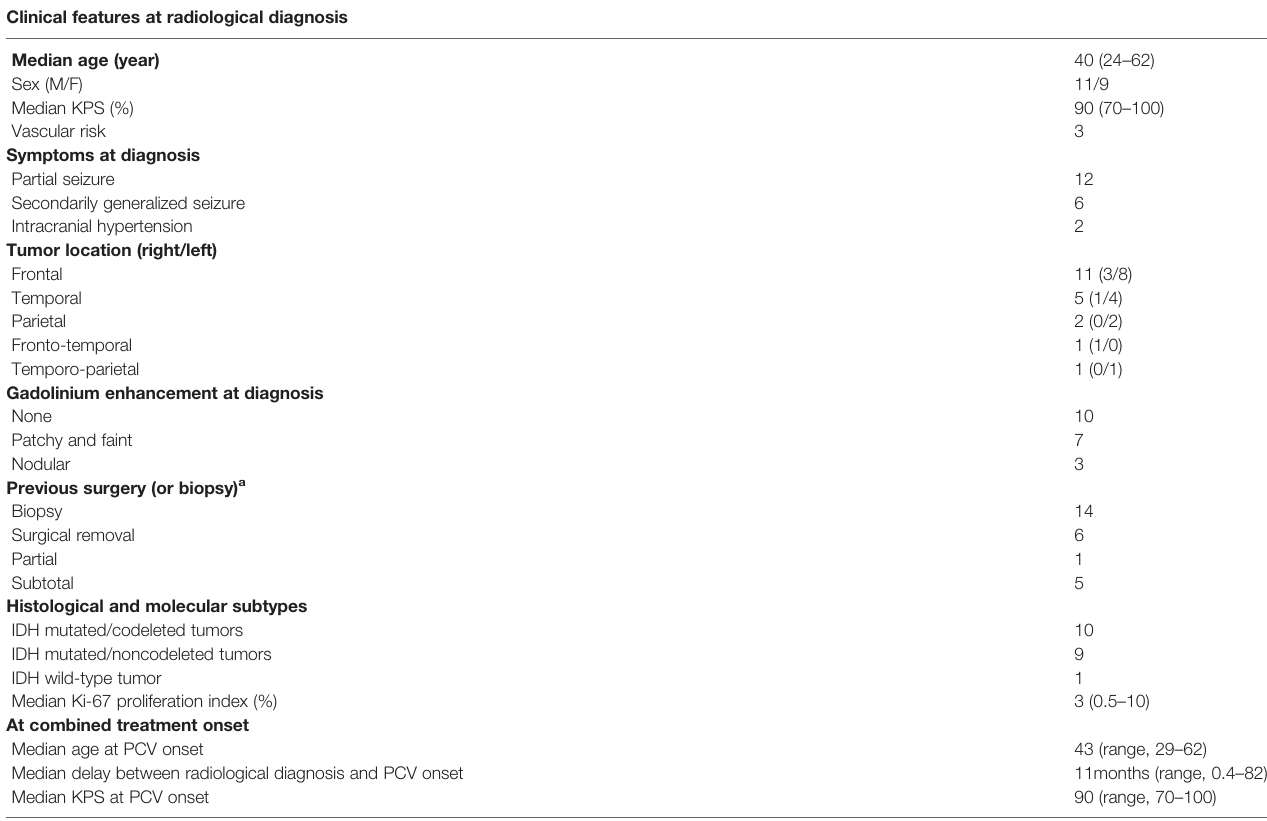
TABLE 1 | Characteristics of the study population ( N =